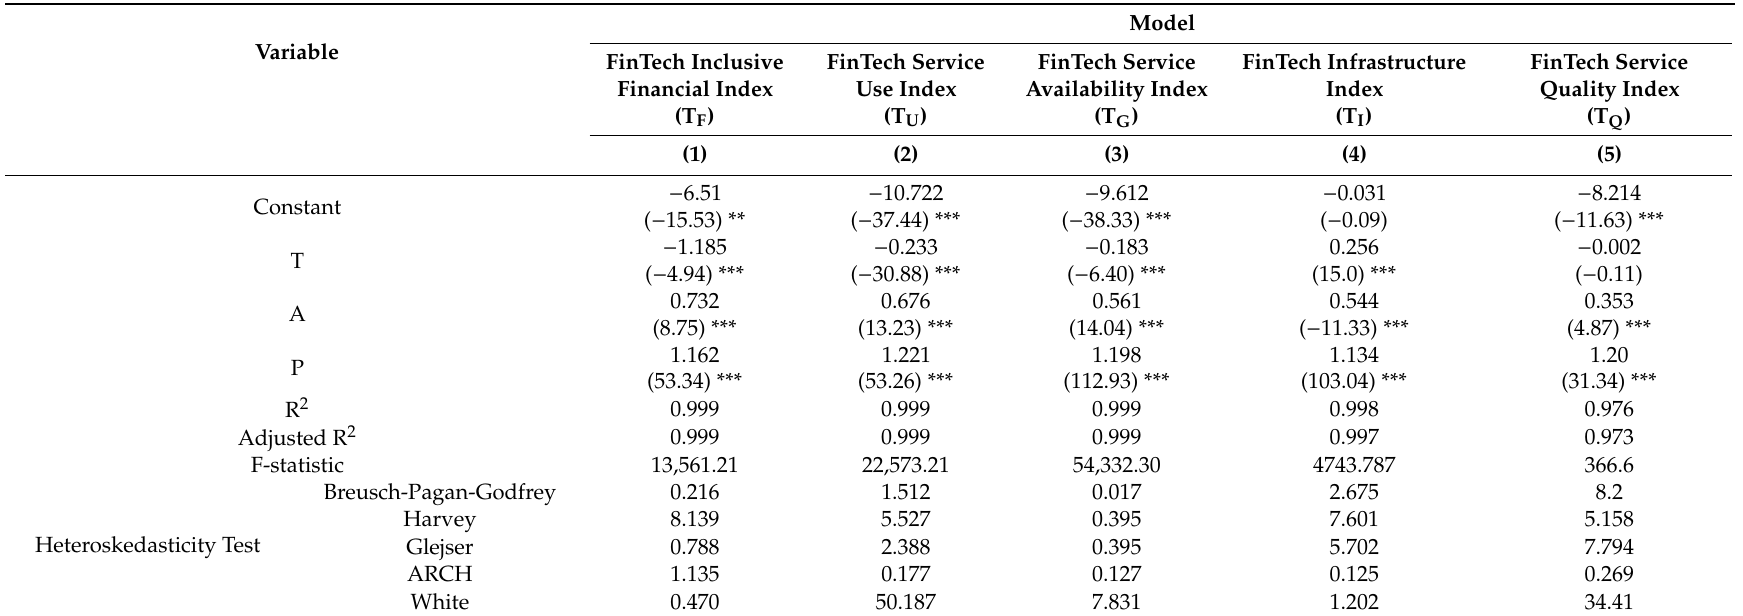
Table 2. “STIRPAT” model estimation